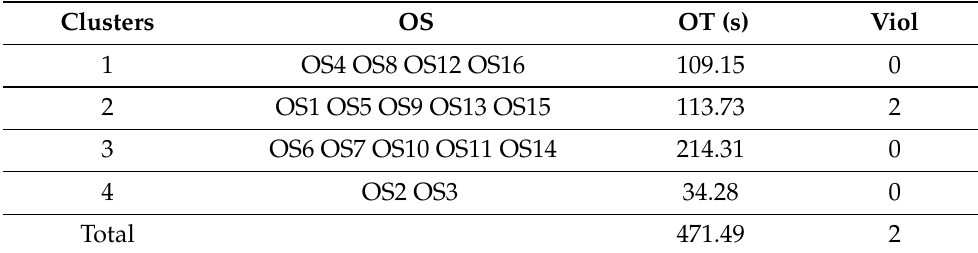
Table 4. Results using K-means clustering as proposed in [20,23].